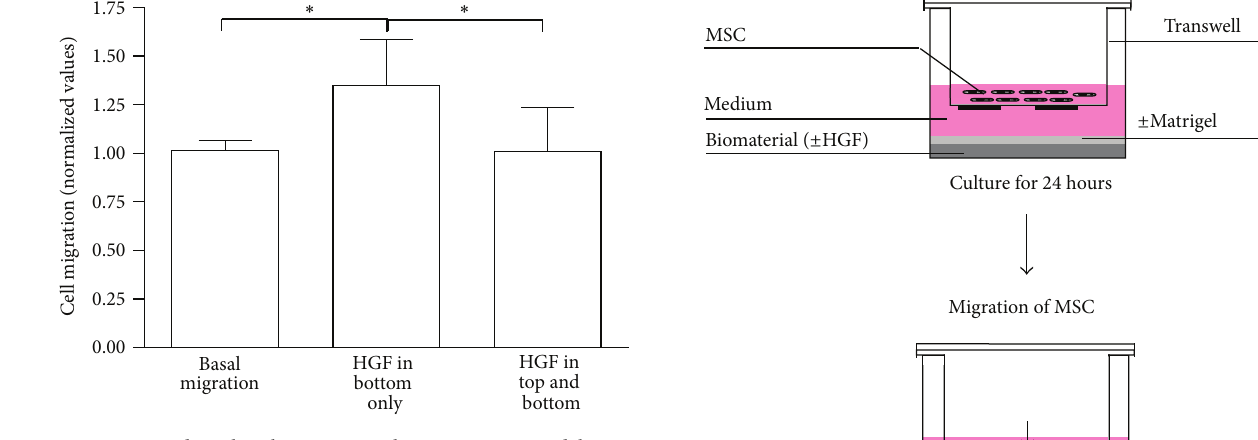
Figure 5: Boyden chamber assay with HGF in top and bottom compartment. All values compared to basal migration and based on 𝑛 = 4 . ∗ 𝑃 < 0.05 .